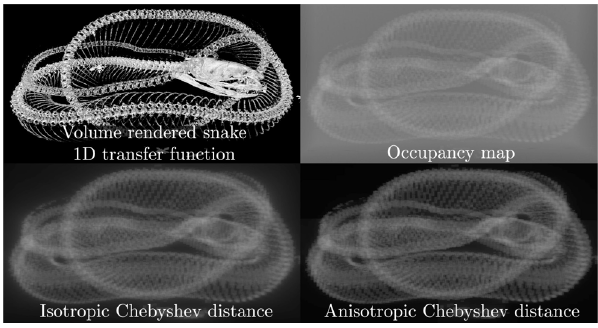
Fig. 4 Relative number of total texture samples (white is more) with each acceleration structure for the “king snake”